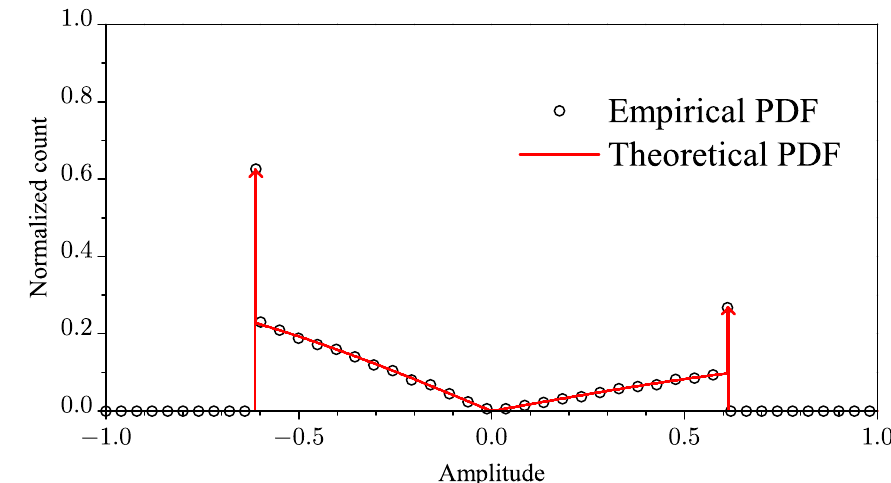
Figure 3. Empirical and theoretical pdfs of the noiseless received symbols transmitted from a single secondary user